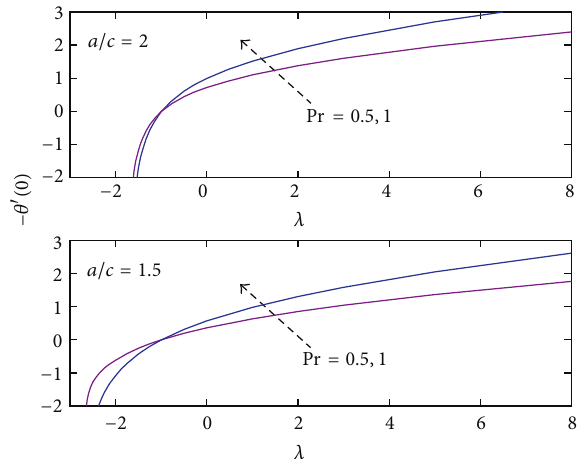
Figure 15: Values of −𝜃 󸀠 (0) versus 𝜆 for various values of 𝑎/𝑐 and